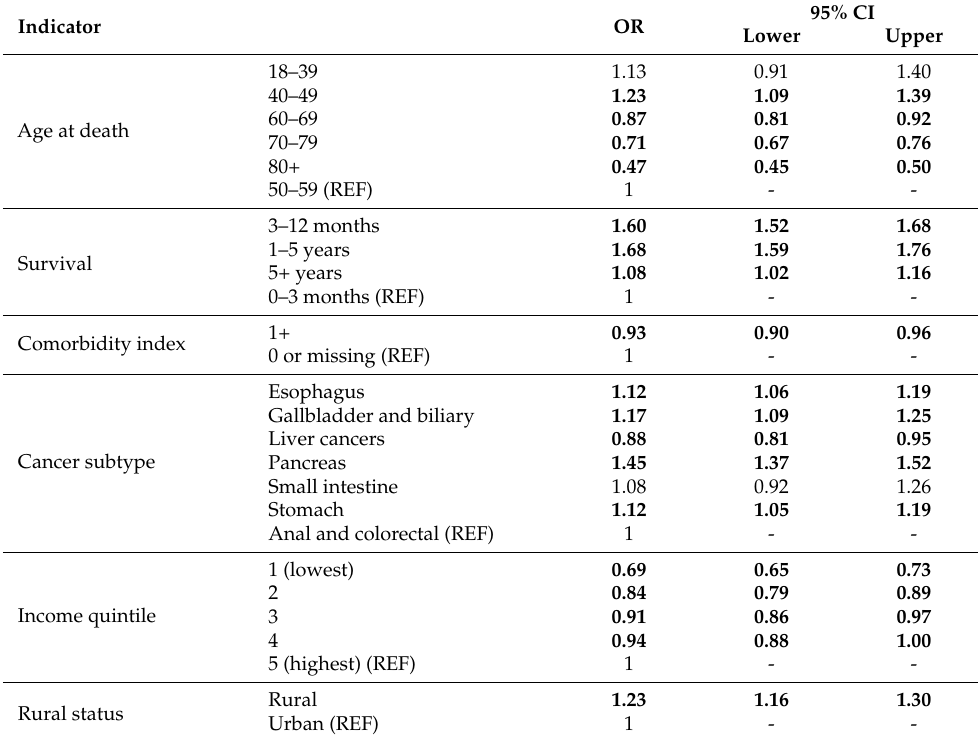
Table 5. Multivariable Logistic Regression for Supportive